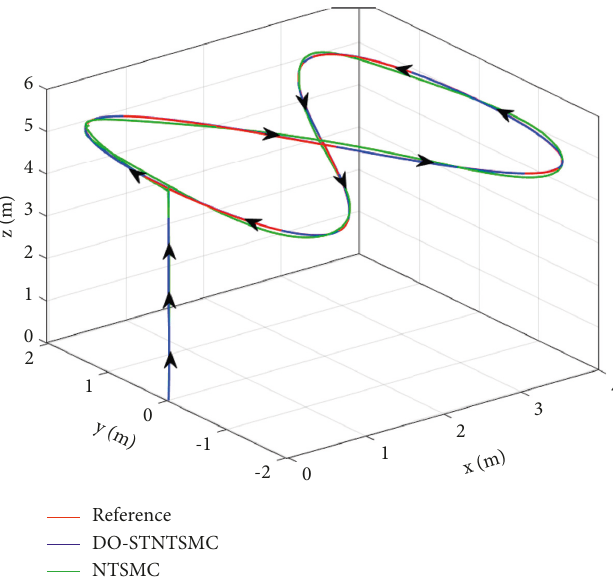
Figure 16: Trajectory tracking in 3D space.